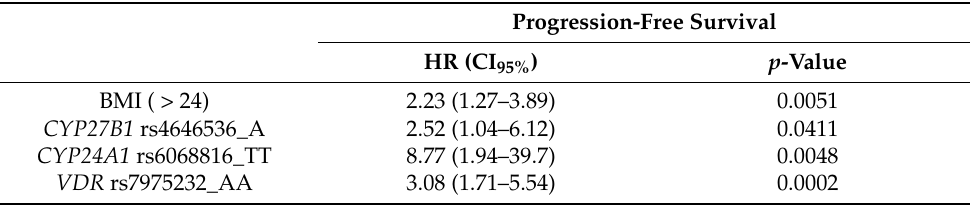
Figure 10. Kaplan–Meier plot of progression-free survival curves with the C allele of the VDR rs7975232 gene polymorphism in the non-resected NSCLC subgroup. Table 8. Influence of gene polymorphisms and clinical characteristic on progression-free survival of non-resected NSCLC patients.